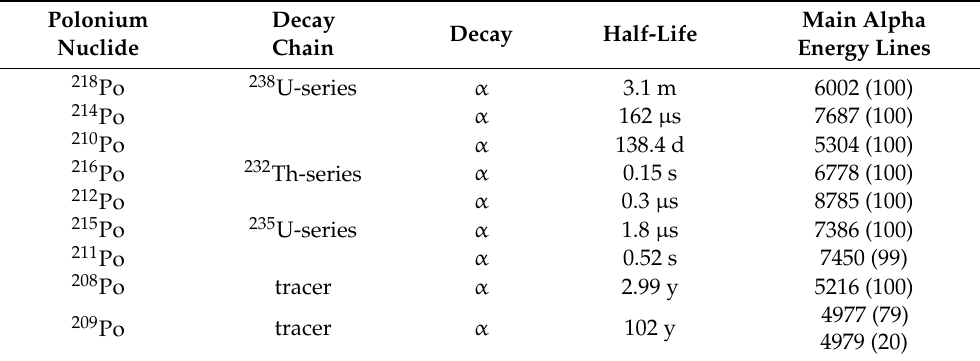
Table 3. Properties of polonium nuclides of the natural decay series and important tracers. Alpha energy lines in keV with emission probability in %. All data from